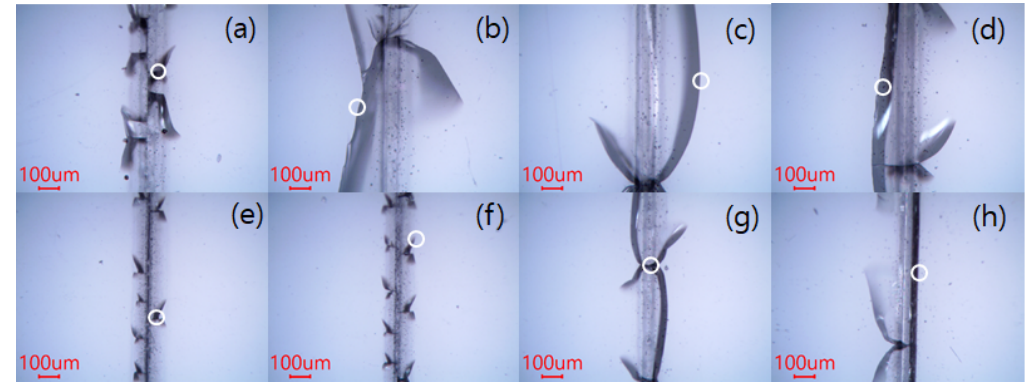
Figure 5. Optical images of the glass surface damaged by a single laser scan with a higher pulse repetition rate. Scan speed: ( a – d ) 5 mm/s and ( e – h ) 15 mm/s. Laser power and pulse repetition rate: ( a , e ) 2.48 W and 50 kHz, ( b , f ) 2.65 W and 60 kHz, ( c , g ) 2.39 W and 70 kHz and ( d , h ) 2.12 W and 80 kHz. The circle in the figure denotes a crack.